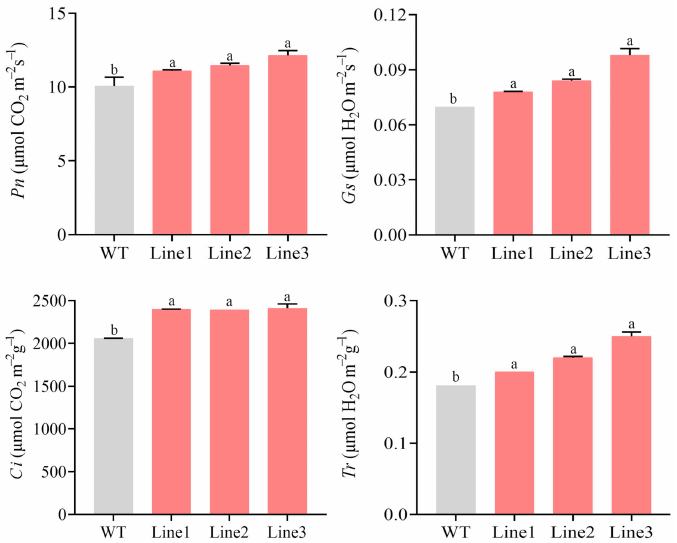
Figure 9. Photosynthetic characteristics of WT and transgenic lines under drought stress. Tobacco plants were stressed by drought for 10 days. The values represent the mean ± SD, and different letters indicate significant differences according to Duncan’s multiple range test ( p < 0.05).